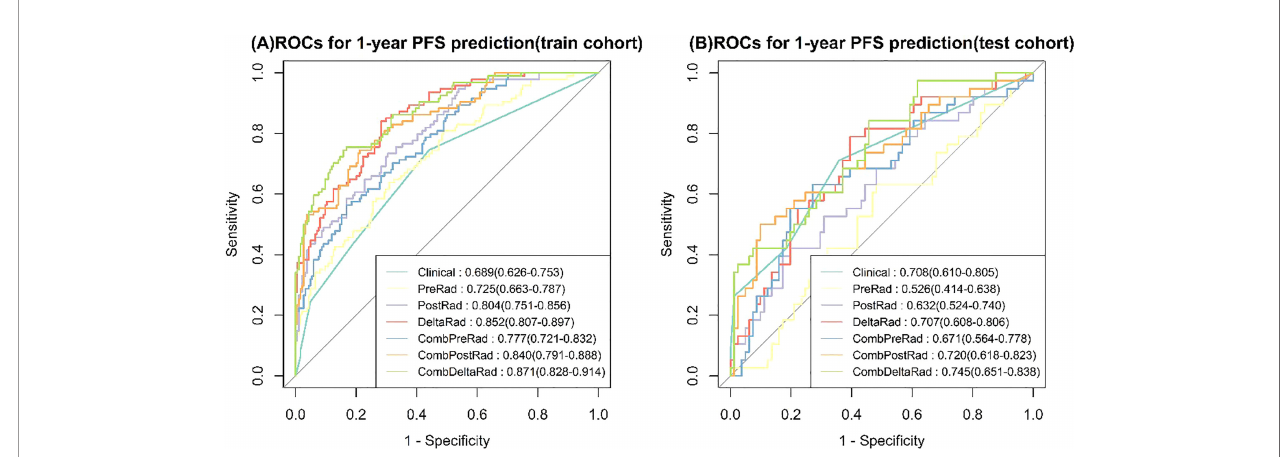
FIGURE 3 | ROCs for 1-year PFS probability prediction of various Models. (A) train cohort, (B) test cohort.